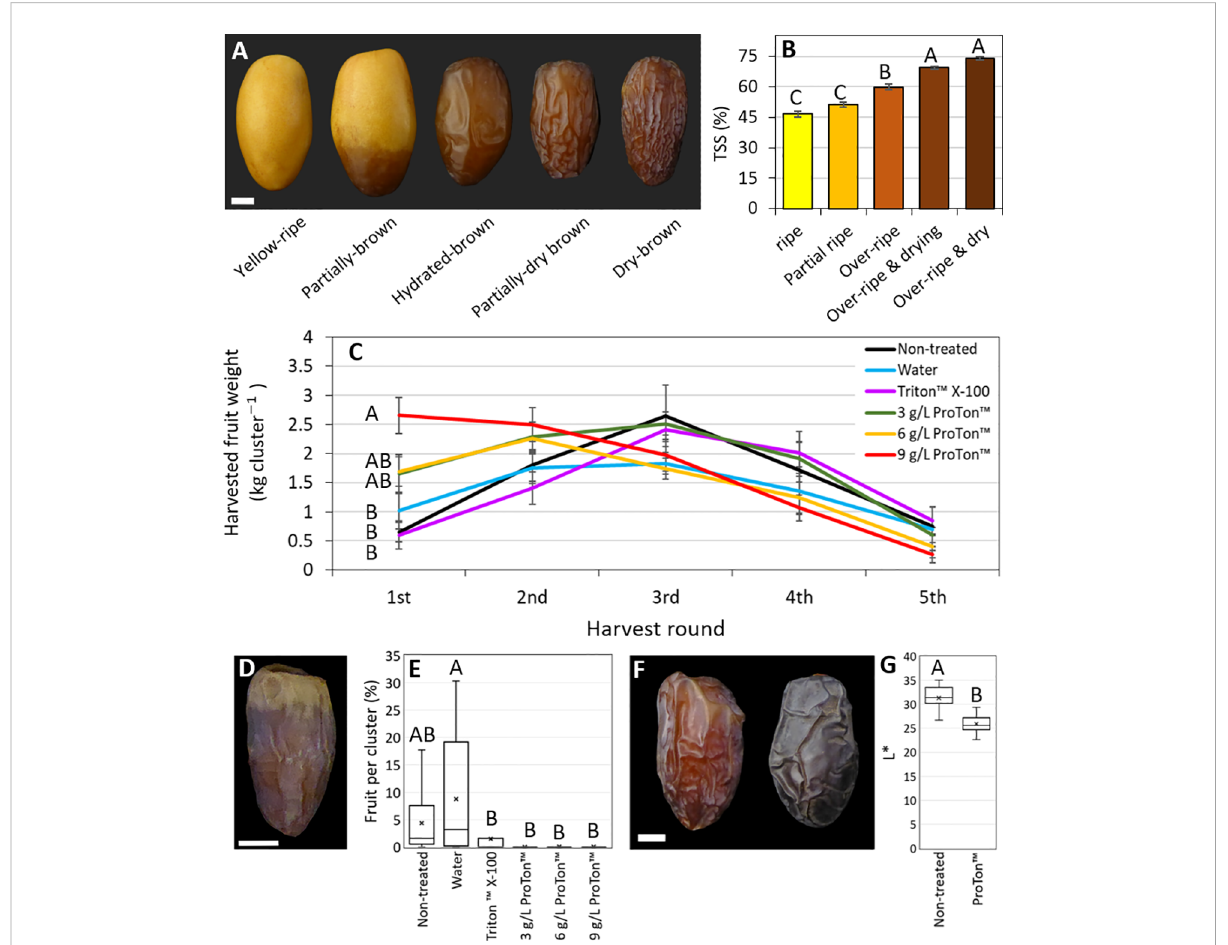
FIGURE 7 Pre-harvest ABA treatments promote fruit harvest and result in darker fruit. In the season of 2020, whole date fruit clusters were treated pre- harvest every three days (four treatments in total) with ABA (ProTone ™ ; 3, 6 or 9 g/L), and Triton ™ X-100, starting from 17 WPP. At harvest, fi ve ripening classes were de fi ned by (A) appearance and (B) total soluble solids % (TSS). (C) The weight of the fruit harvested from the treated clusters at each of the fi ve harvest rounds (one round per week), is shown. (D) Typically, the fi rst harvested fruits of this very arid habitat, are not marketable since they are too dry and do not ripen properly. (E) The percentage of such nonmarketable fruits in the fi rst harvest round of the season was calculated. (F) Fruits treated with ABA appeared darker then the non-treated fruits. (G) Representative fruits per treatment were sampled 77 days after treatment, photographed, and measured for L* parameter of the L*a*b* color space. Error bars indicate standard error (B, C) . X mark indicates mean (E, G) . Data was analyzed using Tukey-Kramer multiple comparison test (B ; p-value < 0.0005, C and E; p-value < 0.05, G; p-value < 0.0001 ) . The number of fruits measured for each class was n=6 (B) . The number of clusters harvested per treatment at each time-point was n=10 (C, E) . The number of fruits measured for each treatment was n=30 (G) . Scale bar: 1 cm (A, D, F)